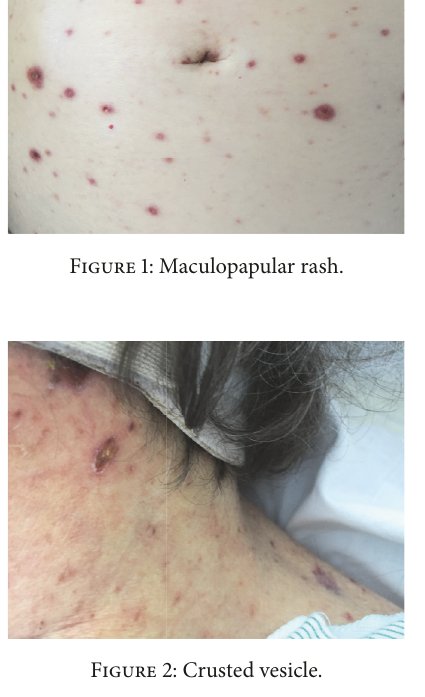
Figure 4: Skin biopsy: intact epidermis on one side and lesion on the other.